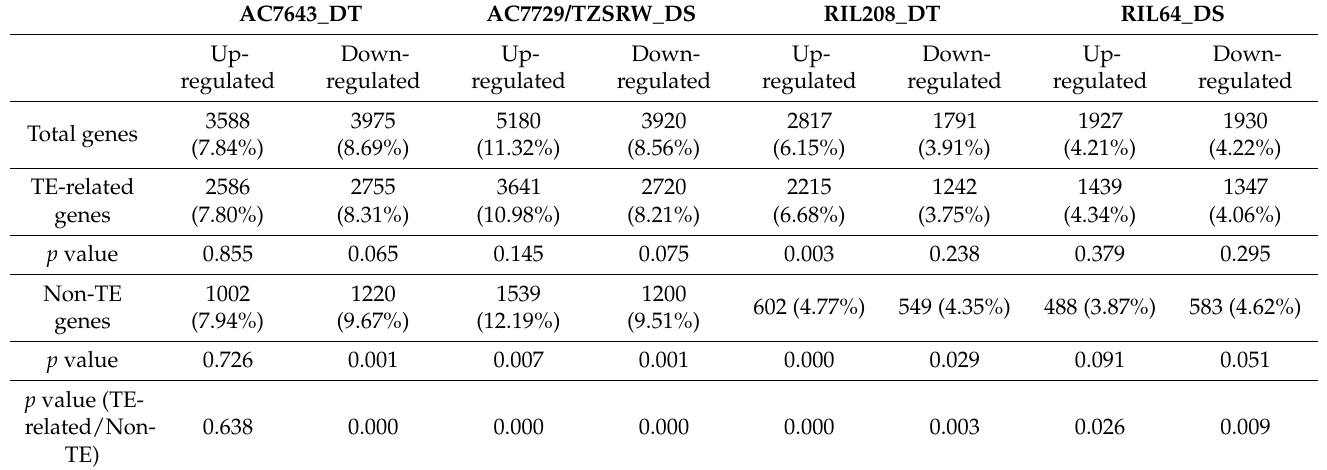
Table 2. The number and proportion of drought responsive genes in four maize inbred